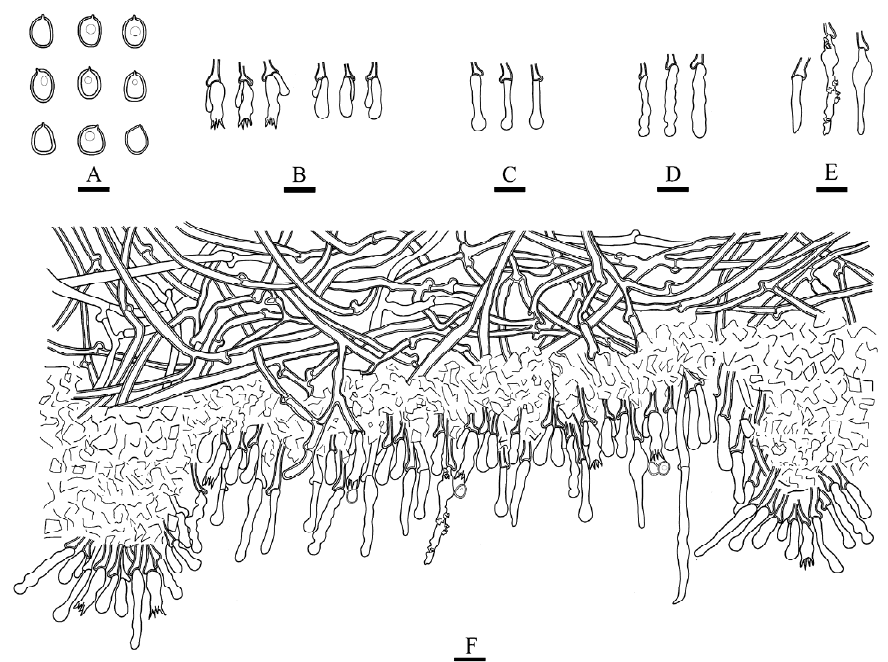
Figure 5. Microscopic structures of Xylodon gossypinus (holotype) ( A ): basidiospores ( B ), basidia and basidioles ( C ), capitate cystidia ( D ), moniliform cystidia ( E ), and subulate cystidia to leptocystidia ( F ). A section of hymenium. Bars: a = 5 µm, b–f = 10 µm.